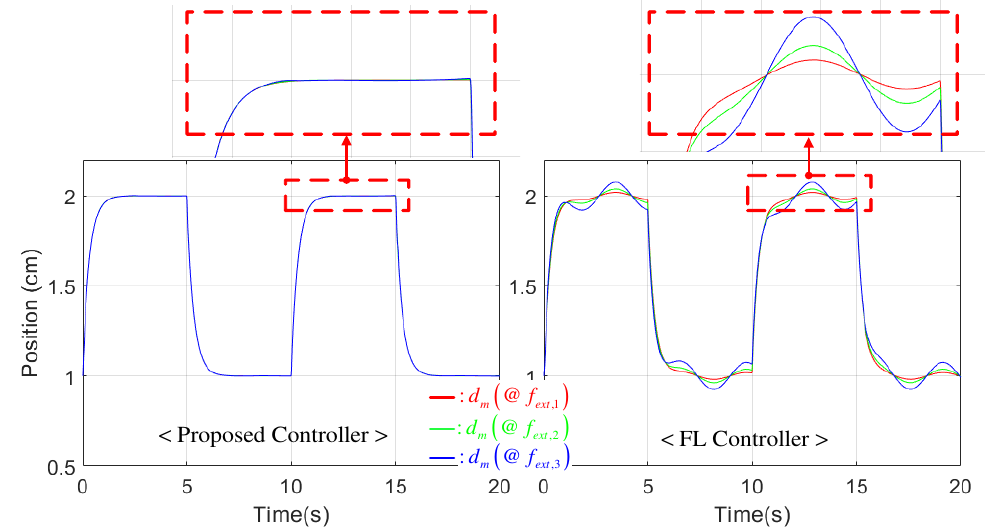
Figure 3. Position tracking performance comparison results under three types of external disturbances of f ext ,1 ( t ) , f ext ,2 ( t ) , and f ext ,3 ( t )